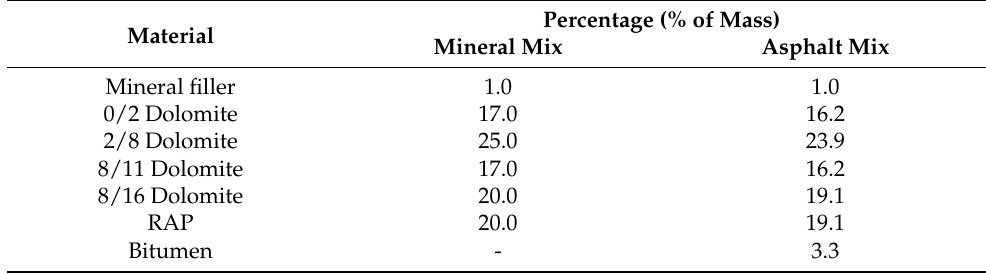
Table 2. Mineral mix and asphalt mix